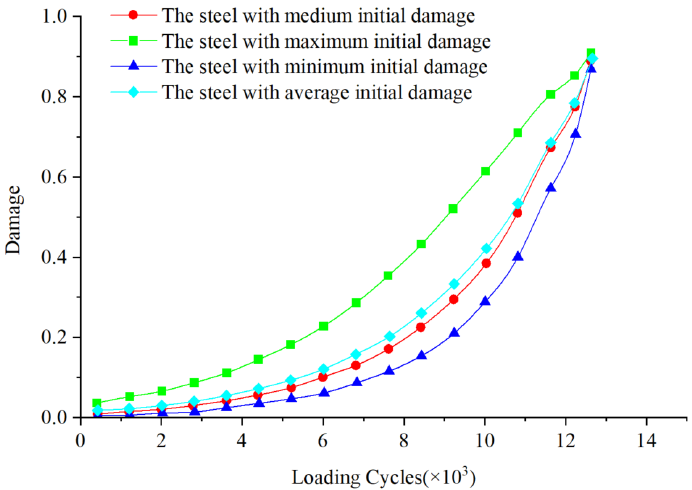
Figure 7. Corrosion fatigue damage curve of the strand with loading times.